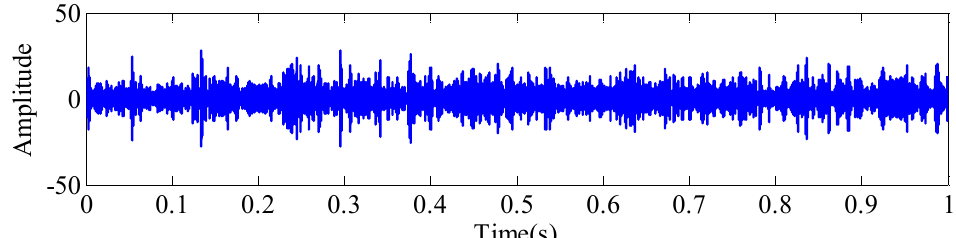
Figure 23. Time domain diagram of the manually selected signal segment.